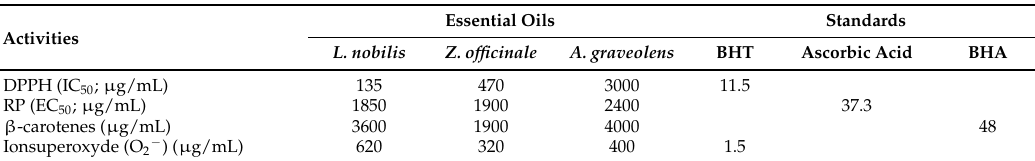
Table 3. Antioxidant activities of the three essential oils tested as compared to standard BHT, BHA and ascorbic